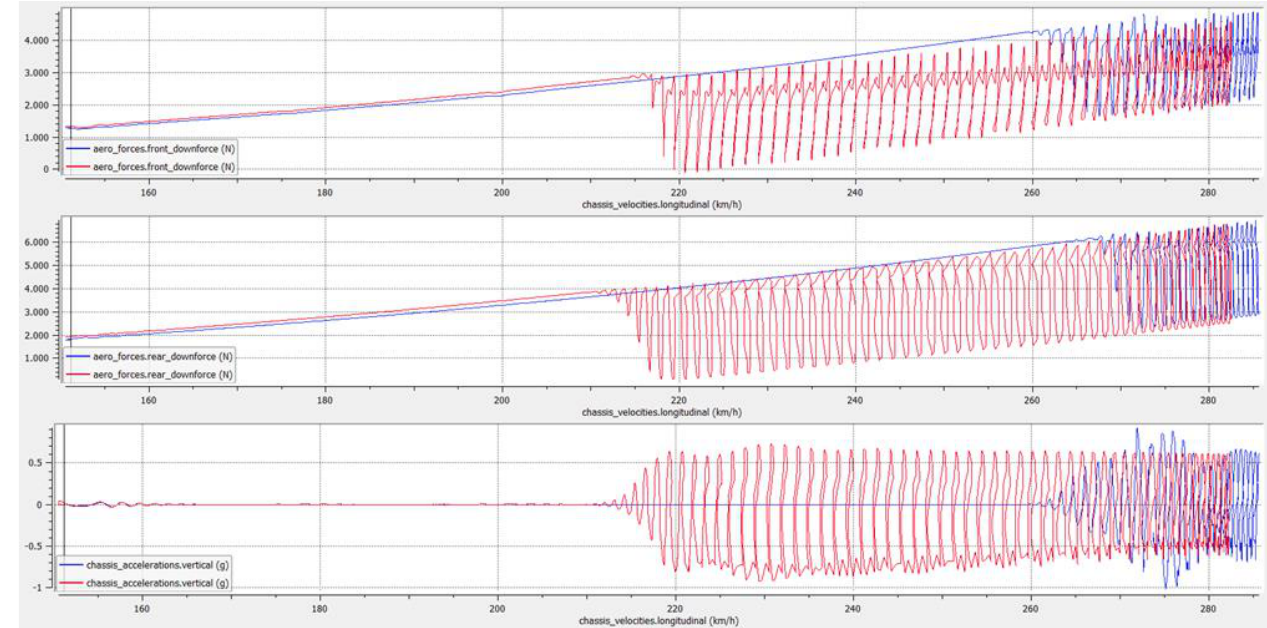
Figure 27. Static ride height variations FRHS +5 mm, RRHS +10 mm (#3, blue): downforce is stable until porpoising is triggered, and higher on average. Efficiency is also improved, and the final simulation speed is higher as well. In this plot front downforce ( top ), rear downforce ( center ) and vertical acceleration ( bottom ) are shown.